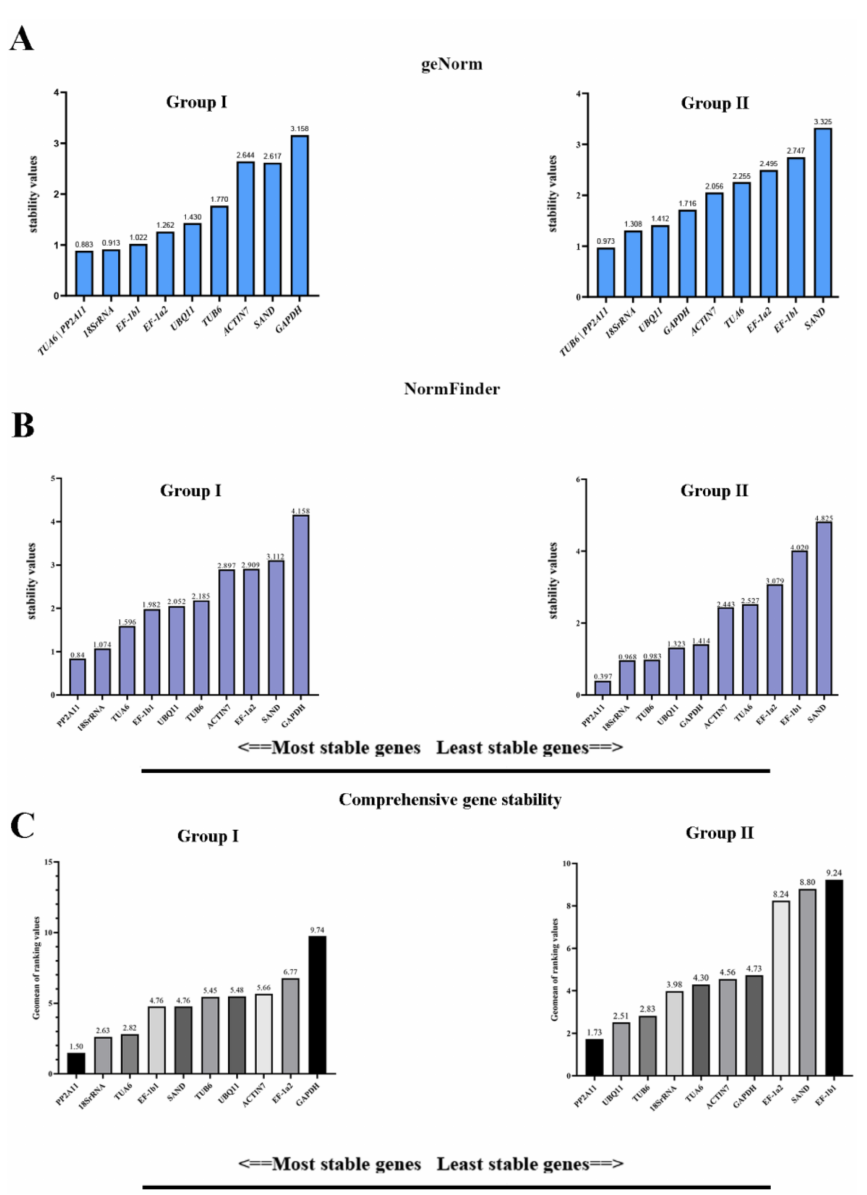
Figure 2. Stability analysis of candidate RGs. ( A ) Stability analysis in geNorm; ( B ) expression of stable value in NormFinder; ( C ) comprehensive ranking of gene